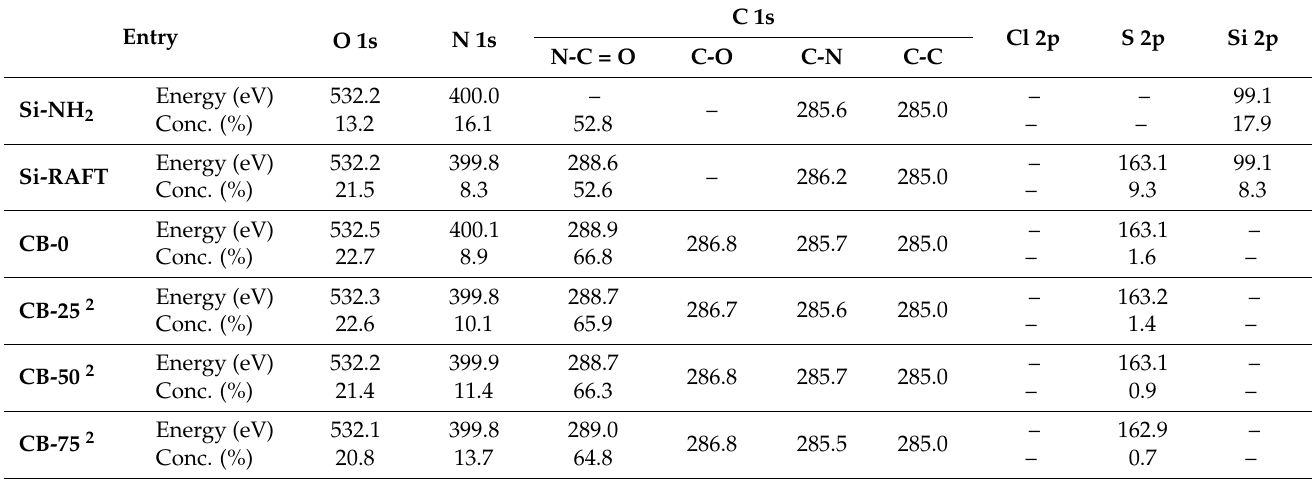
Table 1. Atomic concentration brush-gel layers as determined by XPS analysis 1